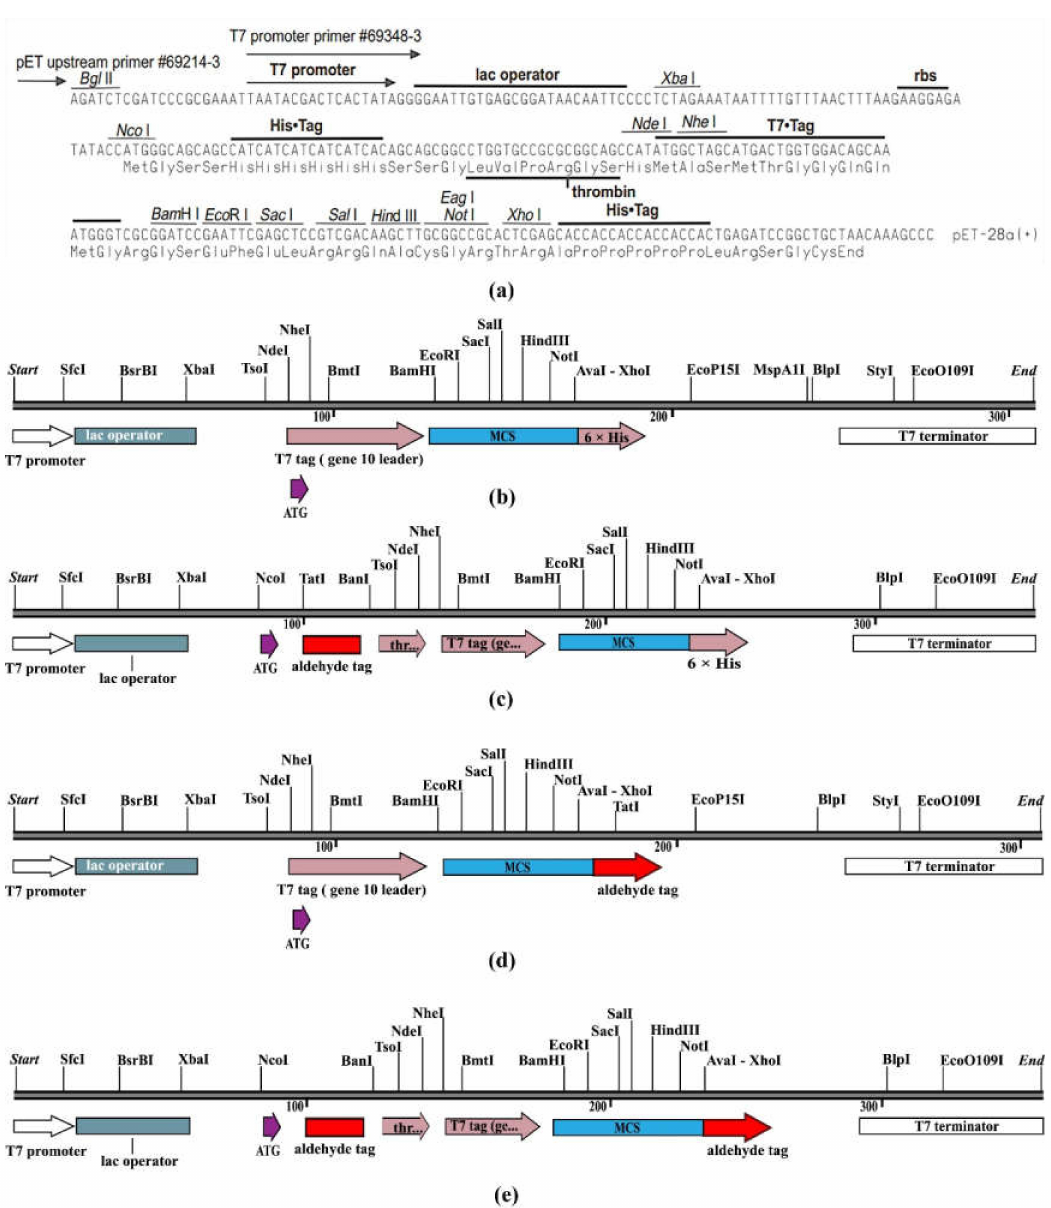
Figure 1. The plasmid maps. ( a ) pET-28a cloning region; ( b ) pET-28a DH cloning region; ( c ) pET-28a NQ cloning region; ( d ) pET-28a CQ cloning region; ( e ) pET28a DQ cloning